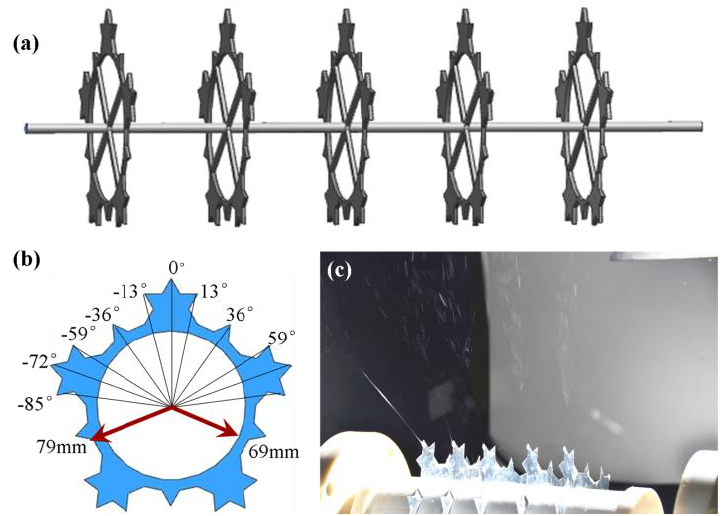
Figure 1. The Von Koch curve-shaped tipped electrospinneret; ( a ) The Von Koch curve-shaped tipped electrospinneret model; ( b ) the specification of the Von Koch electrospinneret; ( c ) the needleless electrospinning process.